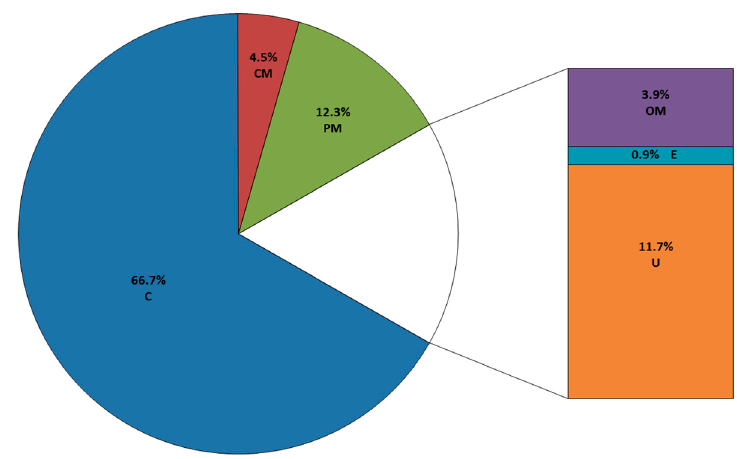
Figure 4. Percentage representation of the subcellular localization of the surface-shaving-identified proteins from B. cenocepacia J2315, as determined by PSORTb 3.0.2. The 333 proteins ( ≥ 5 peptides